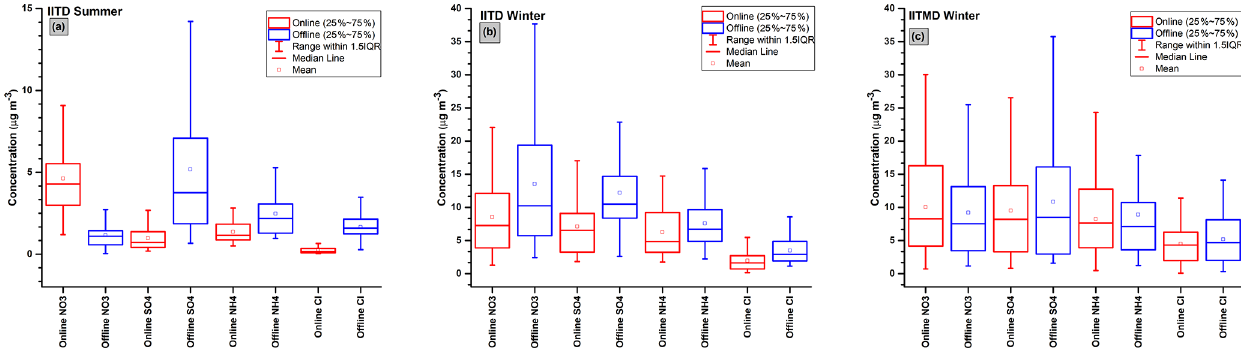
Figure 2. Box plots of online- and offline-measured secondary species (NO 3 − , SO 42 − , and NH 4 + ) and Cl − during the (a) summer campaign at IITD, (b) winter campaign at IITD, and (c) winter campaign at IITMD site. IQR denotes interquartile